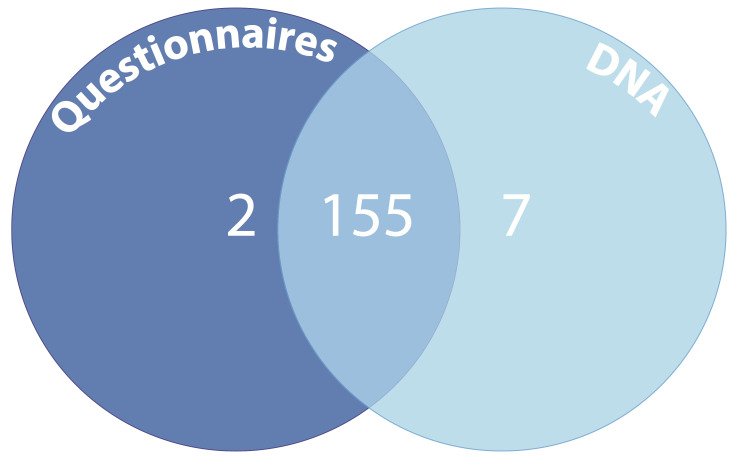
Venn diagram demonstrating the overlap of number of questionnaires received and number of DNA samples received: 2 respondents returned the questionnaire without DNA samples, 7 returned DNA samples without a questionnaire and 155 returned both DNA samples and questionnaire.